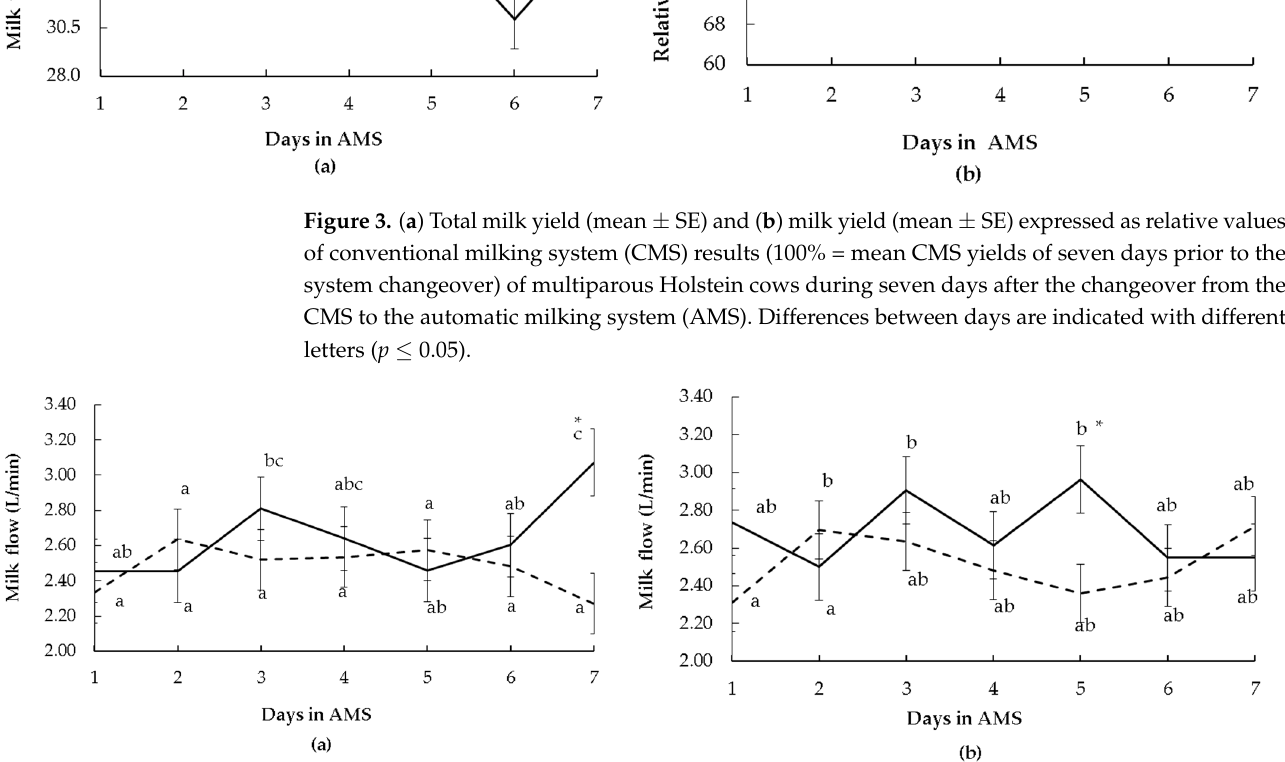
Figure 3 . ( a ) Total milk yield (mean ± SE) and ( b ) milk yield (mean ± SE) expressed as relative values of conventional milking system (CMS) results (100% = mean CMS yields of seven days prior to the system changeover) of multiparous Holstein cows during seven days after the changeover from the CMS to the automatic milking system (AMS). Differences between days are indicated with different letters ( p ≤ 0.05).